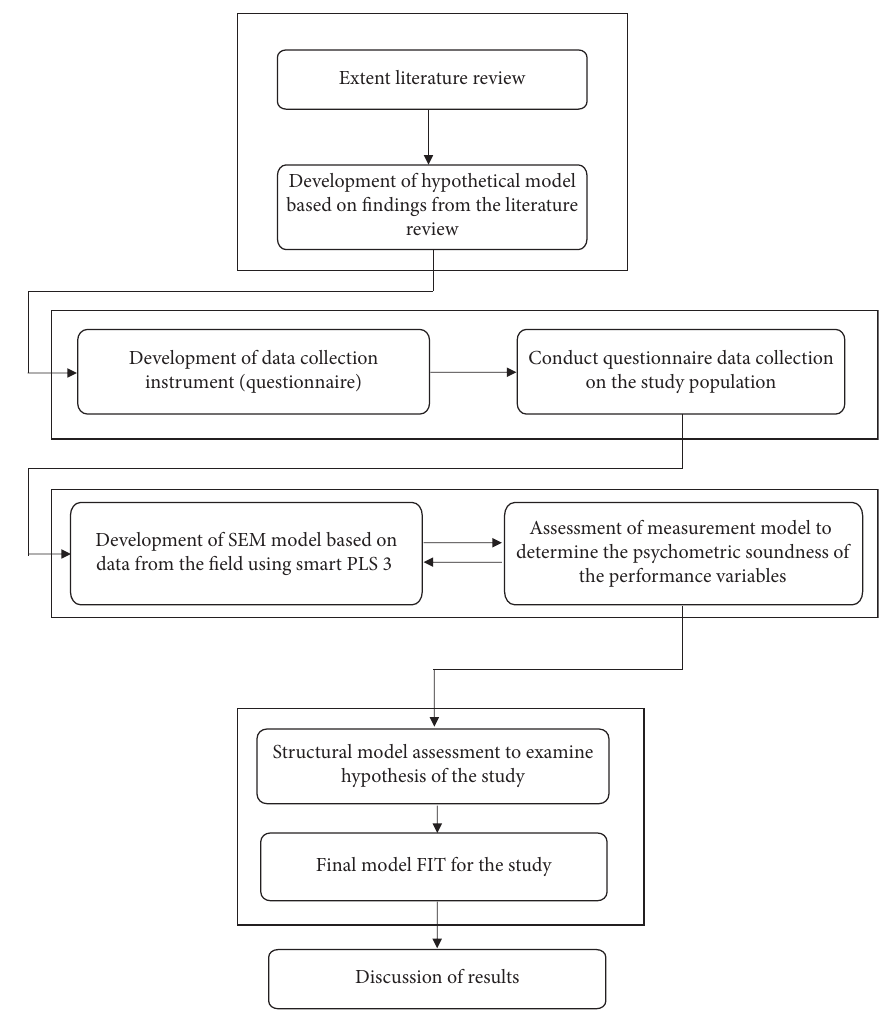
Figure 3: Research